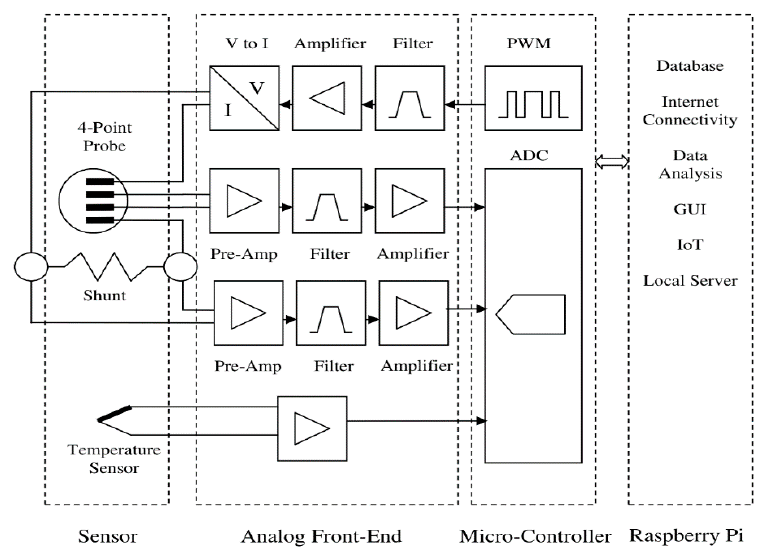
Figure 7. Conductivity measurement circuit block diagram.